Question: What direction does the quantity move in — increasing or decreasing?
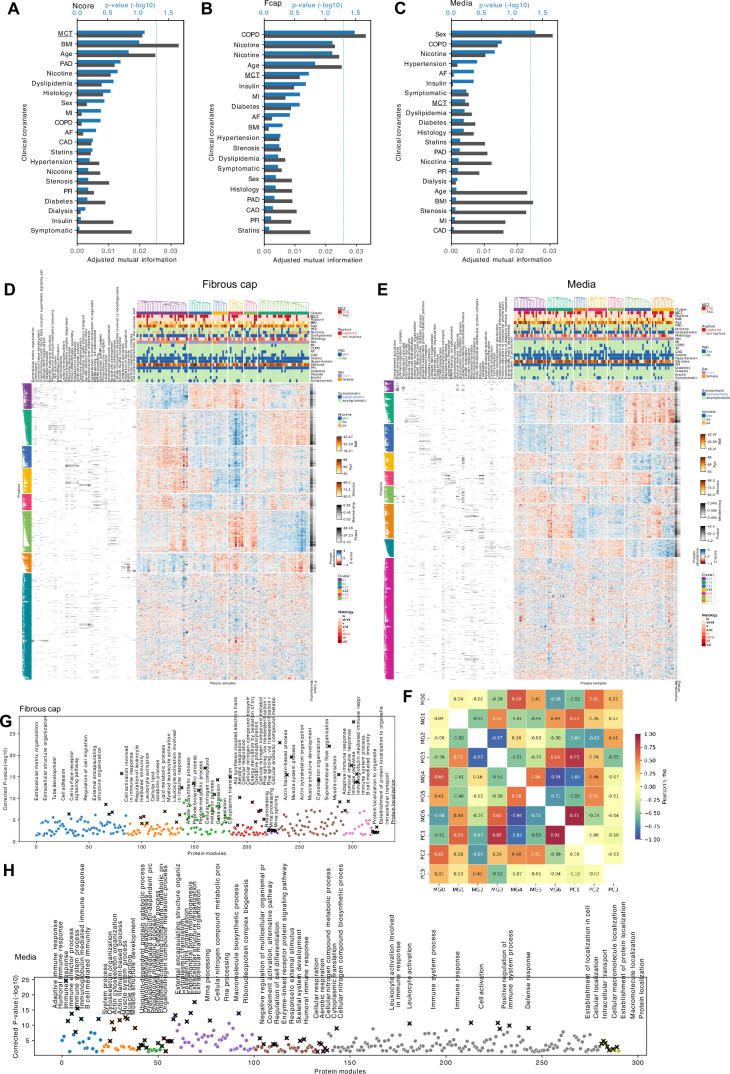
Answer: increasing